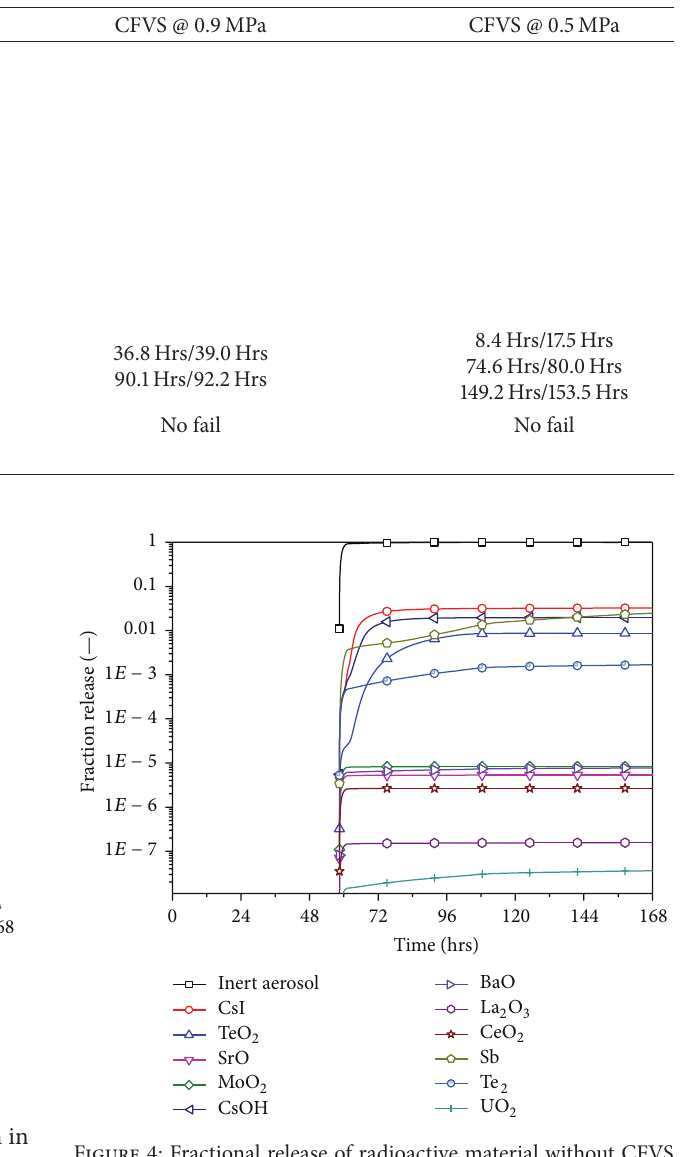
Figure 4: Fractional release of radioactive material without CFVS in extended